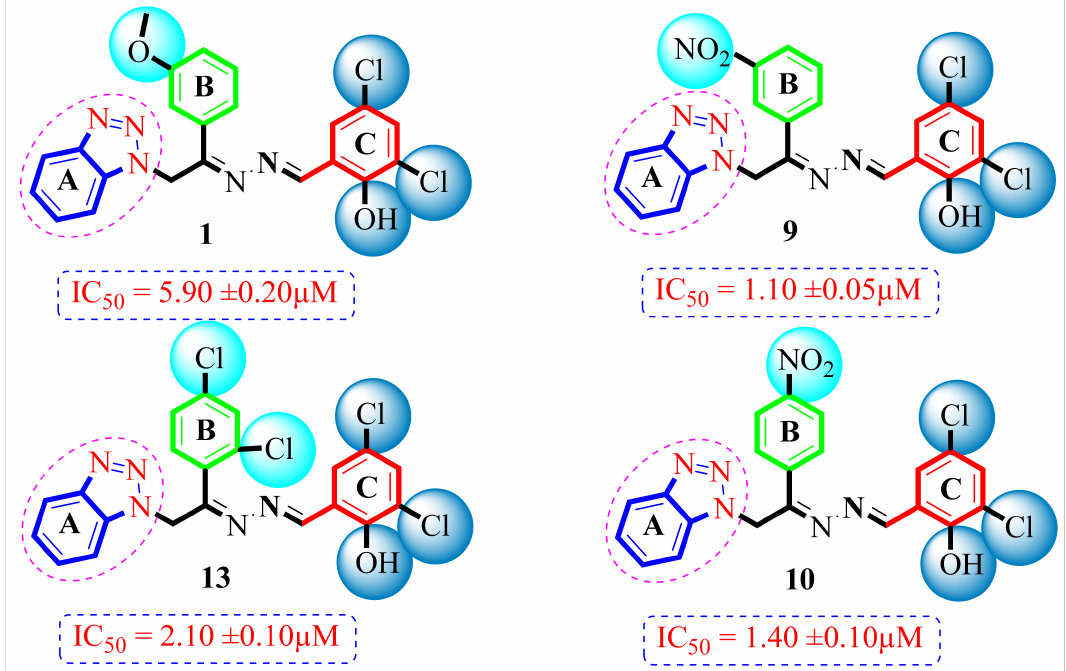
Figure 2. SAR study of analogs 1 , 9 , 10, and 13 .